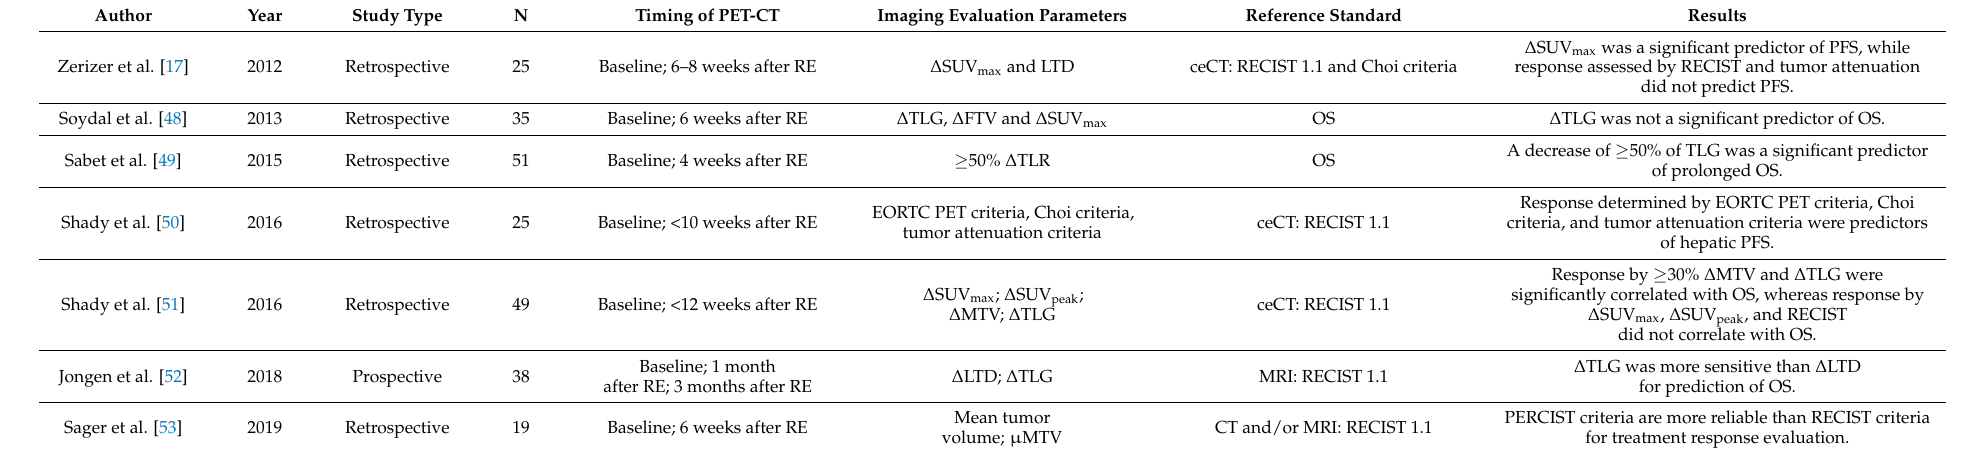
Table 5. Summary of literature studying PET-CT performance after radioembolization of colorectal liver